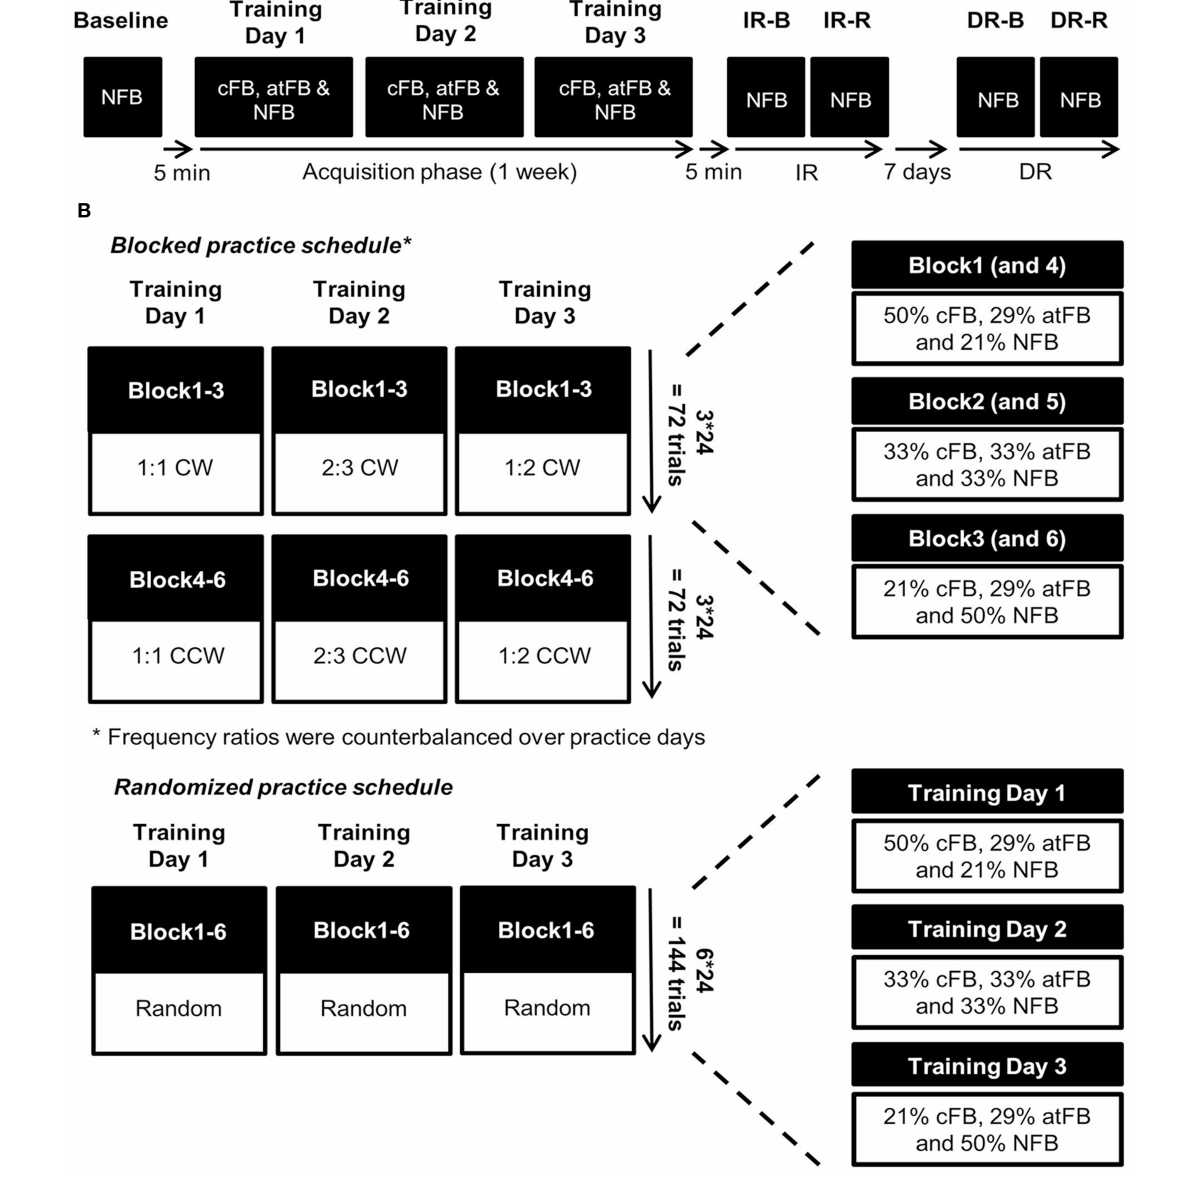
FIGURE 3 | (A) Training protocol . Baseline performance was assessed without any feedback (NFB) on day 1 prior to training. The acquisition phase consisted of three training days within 1 week. Because of the fading feedback schedule, all three feedback conditions were present during each day of training. Immediate retention (IR) was conducted 5min after the end of training day 3 and delayed retention (DR) was conducted 7 days later. Both IR and DR consisted of two types of retention schedule, i.e., a blocked (IR-B and DR-B) and a random (IR-R and DR-R) schedule. (B) Blocked and random practice schedules. Subjects following blocked practice were exposed to one frequency ratio in both clockwise (CW; blocks 1–3) and